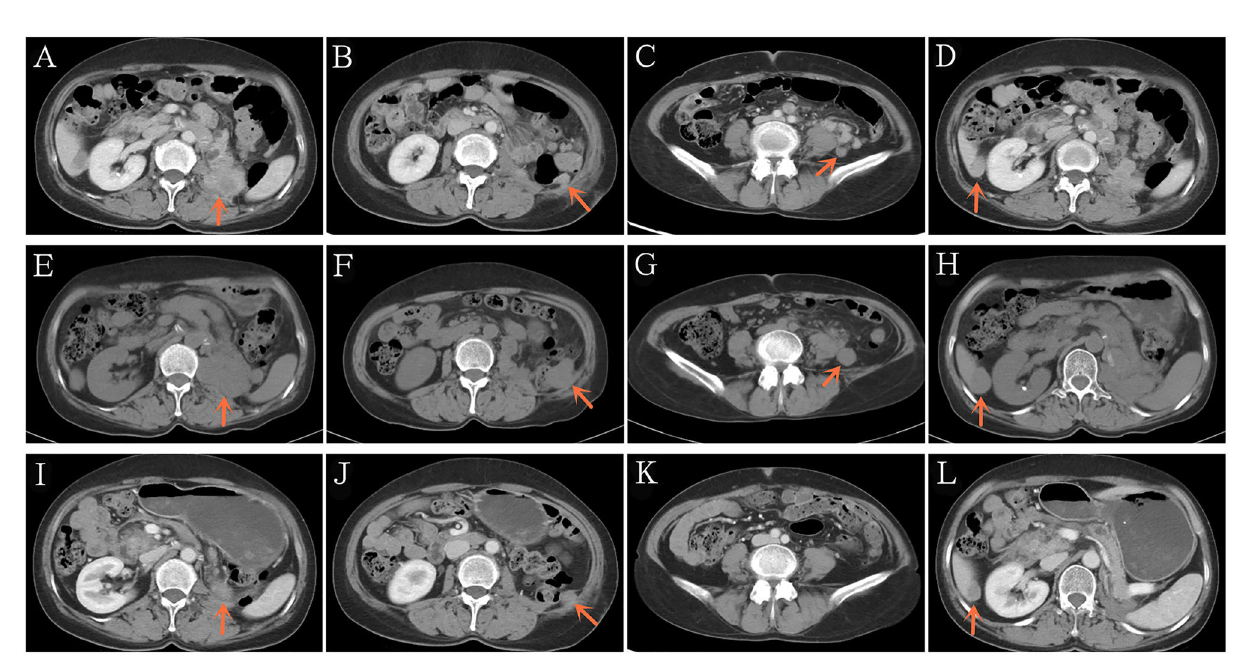
FIGURE 2 | Representative computed tomography showing recurrence after 3 months of post-operative adjuvant anti-PD-1 therapy (A – D) . Disease continued to progress after 2 additional months of standard-dose axitinib plus anti-PD-1 therapy (E – H) . Signi fi cant reduction in the tumor burden after 2 additional months of low- dose axitinib plus anti-PD-1 therapy (I – L) . PD-1/PD-L1, Programmed death-1/programmed death